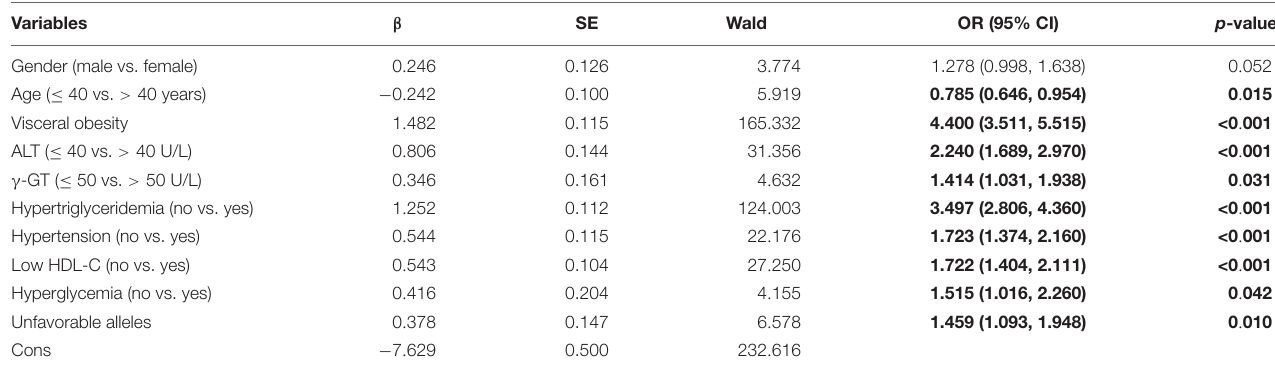
TABLE 4 | Multivariate stepwise regression analysis on influence factors for NAFLD